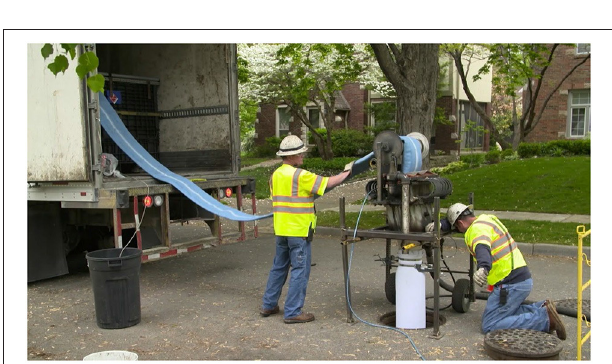
FIGURE 4 | Equipment used during the installation of CIPP. https://www.